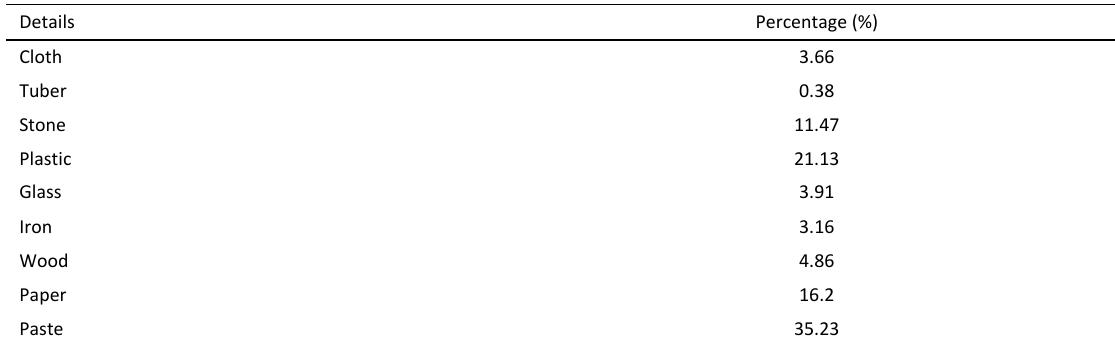
Table 4: Physical properties of MSW